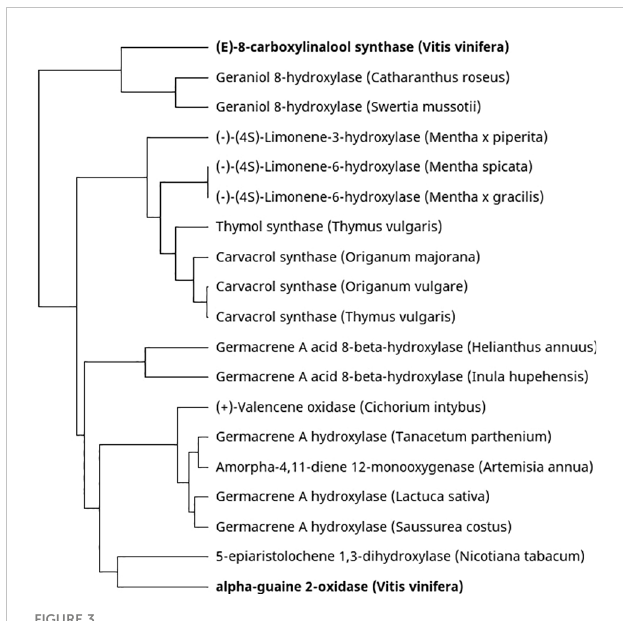
FIGURE 3 Phylogenetic tree of characterised cytochrome P450 monooxygenases which use mono- or sesquiterpenes as a substrate. The characterised V. vinifera CYPs are shown in